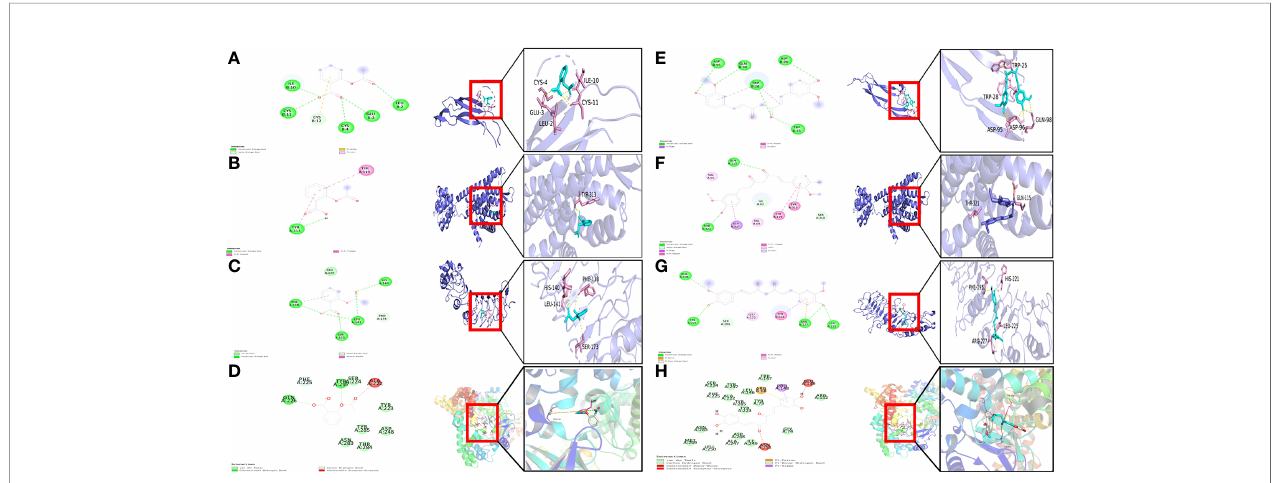
FIGURE 8 | Visualization of docked poses of aspirin and curcumin with their protein target. (A) Binding interactions of aspirin with active site residues of INHBA-1nys; (B) Binding interactions of aspirin with active site residues of OPRK1-4djh; (C) Binding interactions of aspirin with active site residues of TPBG- 4cnc; (D) Binding interactions of aspirin with active site residues of RELA-3qxy; (E) Binding interactions of curcumin with active site residues of INHBA-1nys; (F) Binding interactions of curcumin with active site residues of OPRK1-4djh; (G) Binding interactions of curcumin with active site residues of TPBG-4cnc; (H) Binding interactions of curcumin with active site residues of